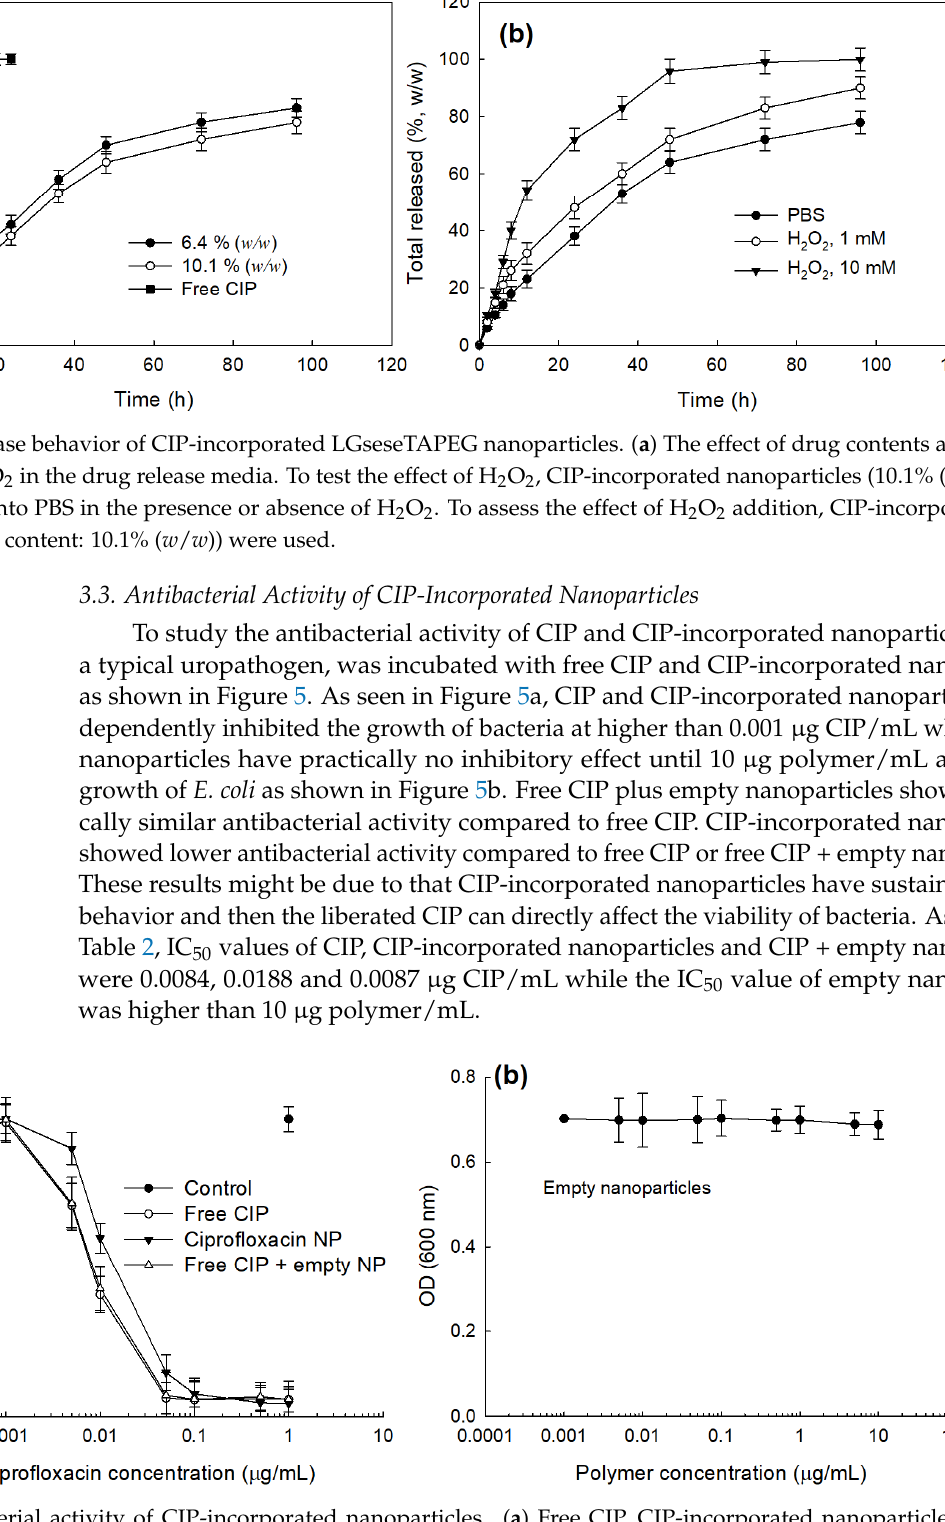
Figure 5. Antibacterial activity of CIP-incorporated nanoparticles. ( a ) Free CIP, CIP-incorporated nanoparticle (CIP-incorporated NP) or free CIP+empty nanoparticles (Free CIP + empty NP). For control, PBS was used to treat bacteria. ( b ) Empty nanoparticles. PBS (pH 7.4, 0.01 M) was used for control treatment. To assess the antibacterial activity of CIP-incorporated nanoparticles, CIP-incorporated nanoparticles (drug content: 10.1% ( w / w )) were used.